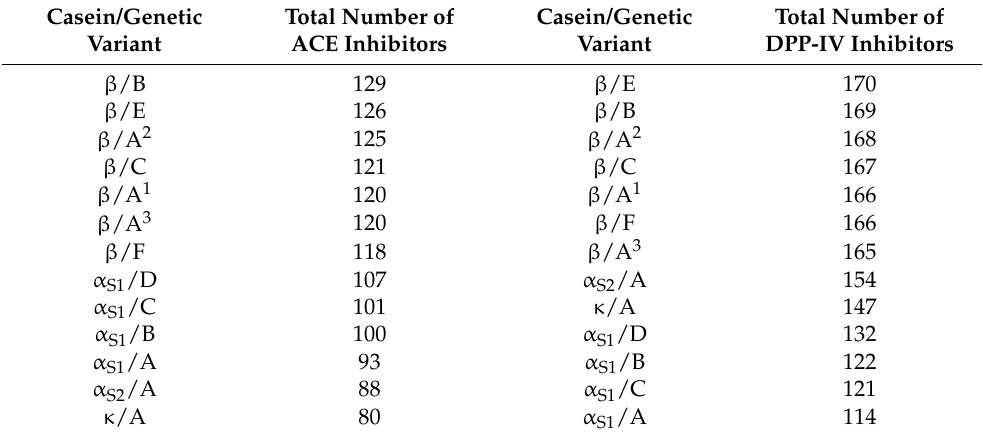
Table 2. “Ranking” of casein sequences as the best potential sources of ACE- and DPP-IV inhibitors 1